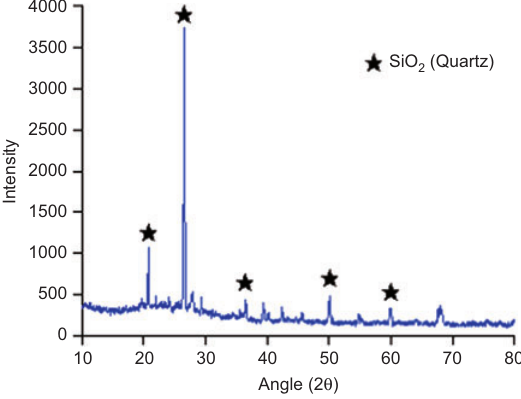
Figure 1 SEM micrograph of SCBA ( × 1K). Figure 2 XRD pattern of